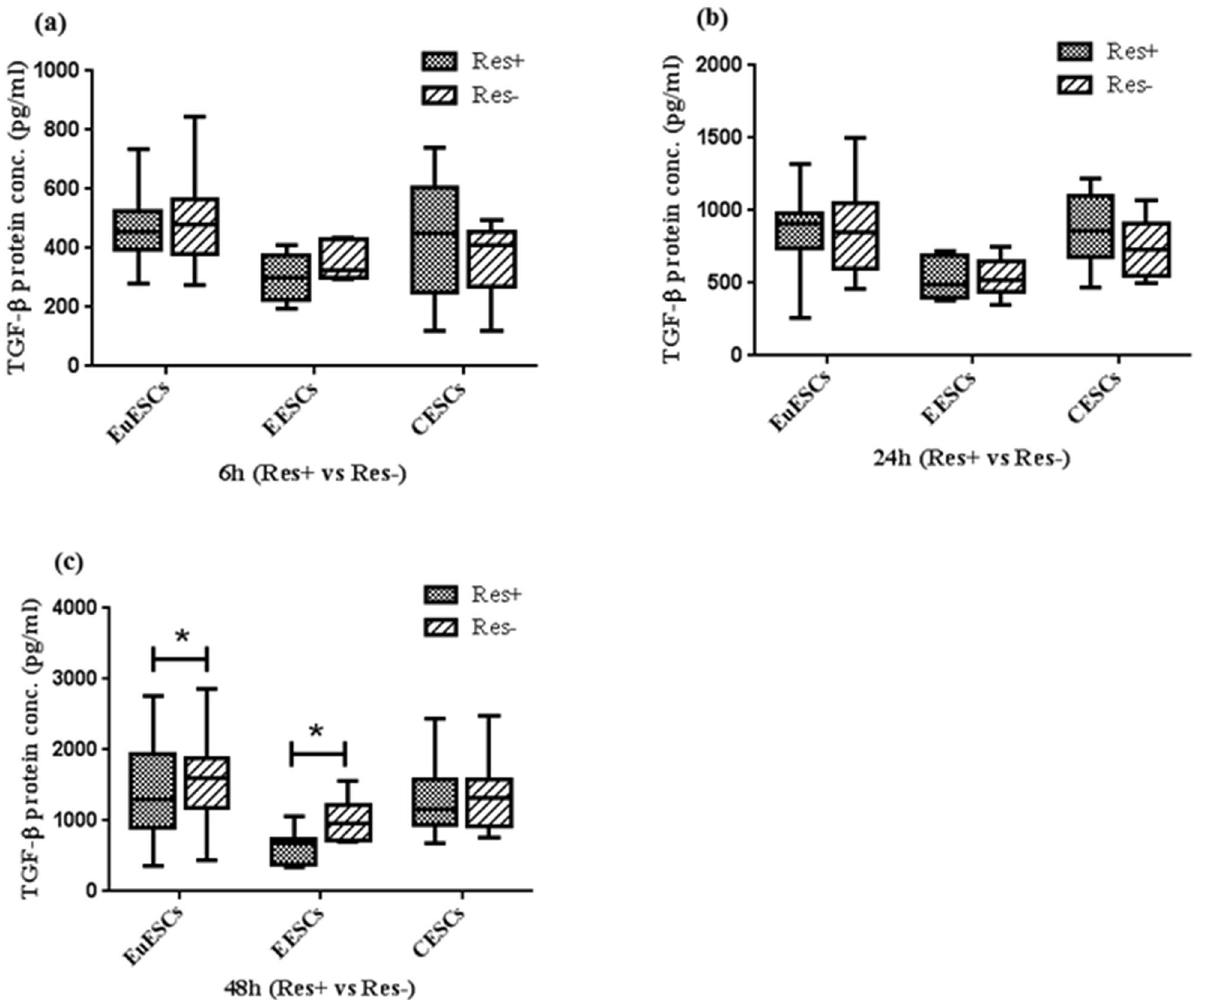
Figure 3. Resveratrol Decreased the Expression of TGF-β Protein in EuESCs and EESCs. ESCs from endometriotic women (8 EESCs and 13 EuESCs) and non-endometriotic controls (11 CESCs) were cultured with or without of 100 µM resveratrol. After 6, 24, and 48 h, the protein expression of TGF-β was examined using ELISA. ( a ) 6 hr (Res + vs Res-), ( b ) 24 hr (Res + vs Res-), ( c ) 48 hr (Res + vs Res-). *P-value < 0.05 by non- parametric tests. TGF-β: Transforming growth factor-β, EuESCs: Eutopic endometrial stromal cells, EESCs: Ectopic endometrial stromal cells, CESCs: Control endometrial stromal